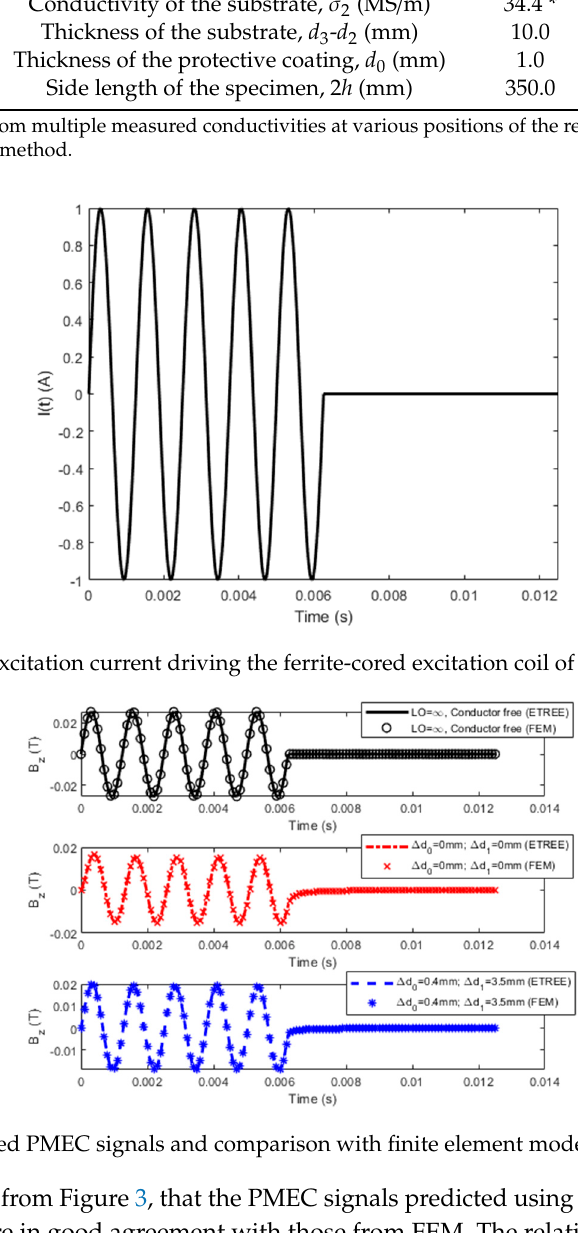
Sensors 2019 , 19 , x FOR PEER REVIEW